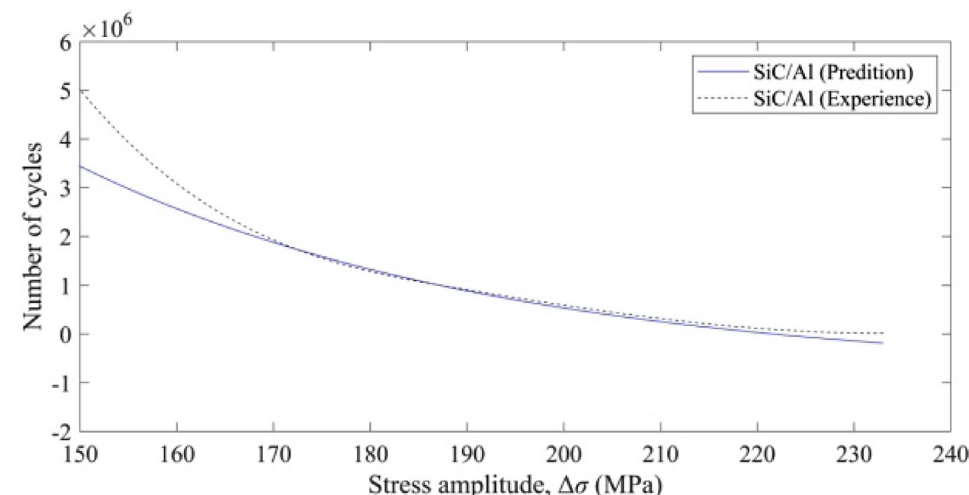
Figure 9 Comparison of experience data and fitting curve in SiC/Al composites